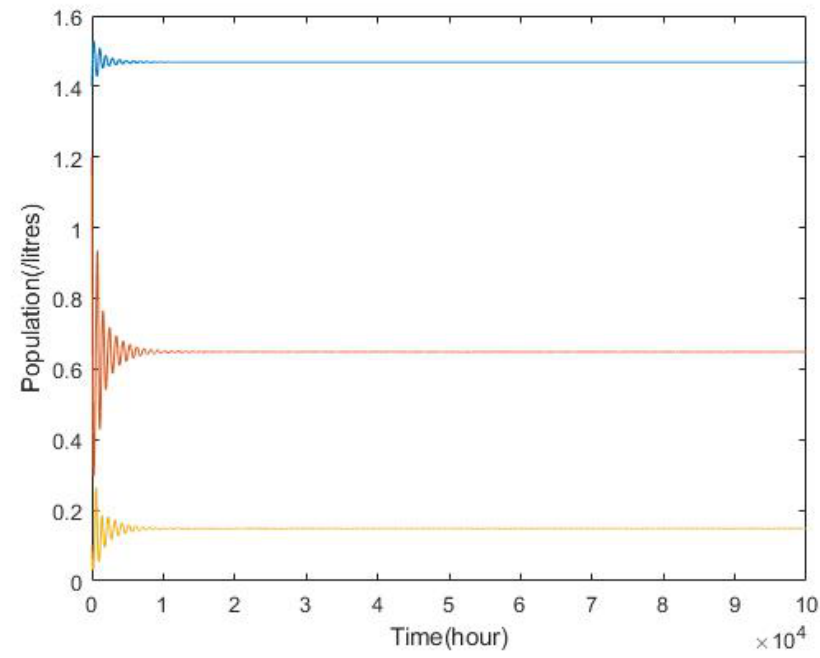
Figure 21. Simulation results of System (16) for τ = τ −